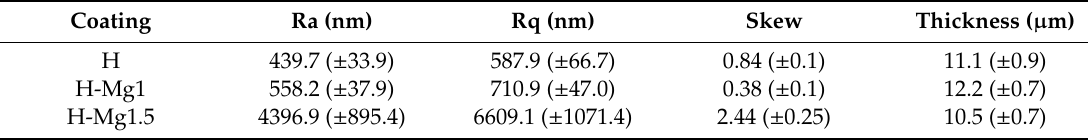
Table 4. Roughness parameters (Ra-average roughness, Rq-root mean square, Skew-skewness) and thickness of the investigated